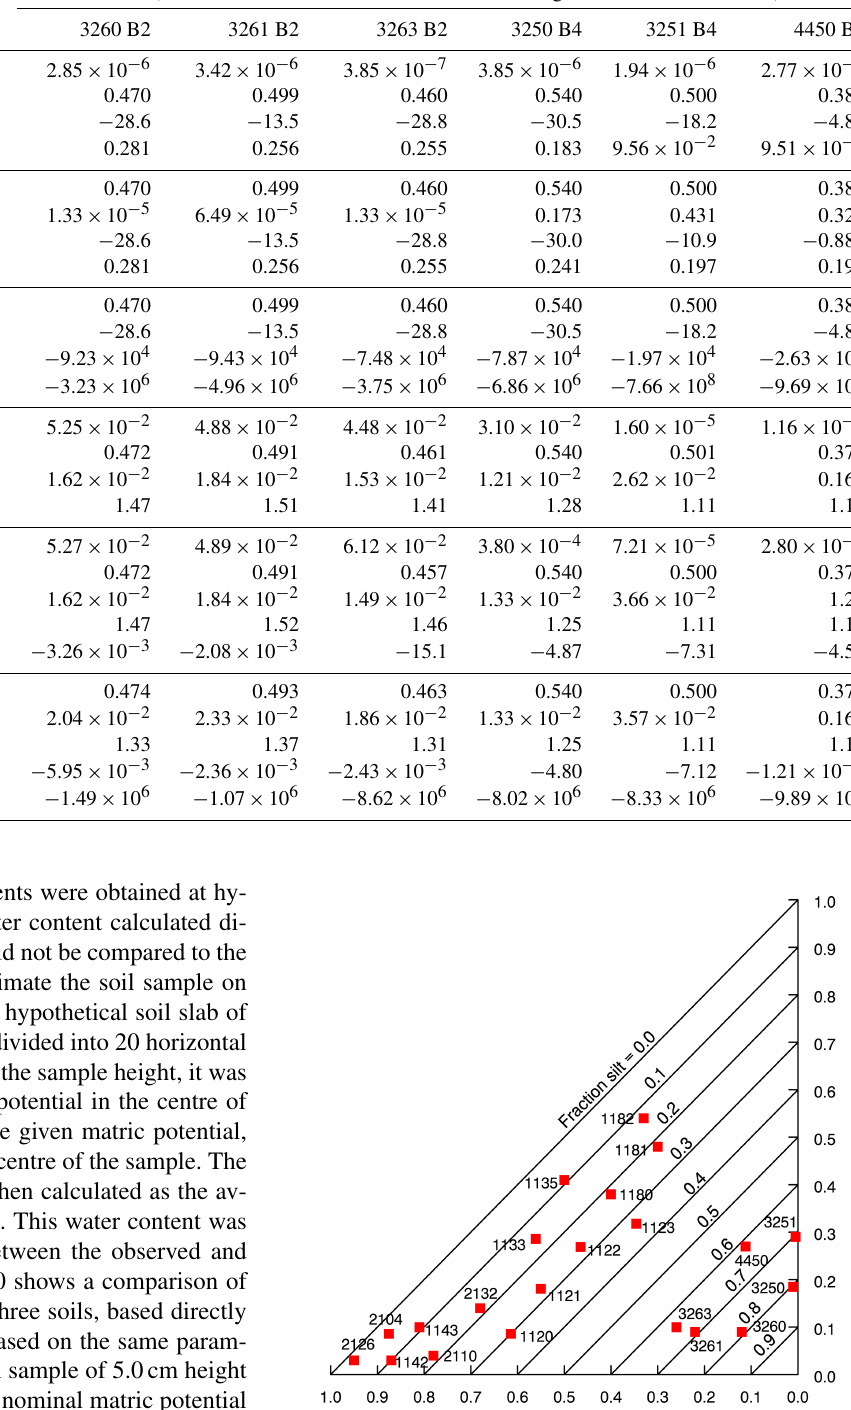
Table C3. The fitting parameters and their values for six parameterizations for silty soils from the UNSODA database (National Agricultural Library, 2015; Nemes et al., 2001). The three-character parameterization label is explained in the main text. Parameterization